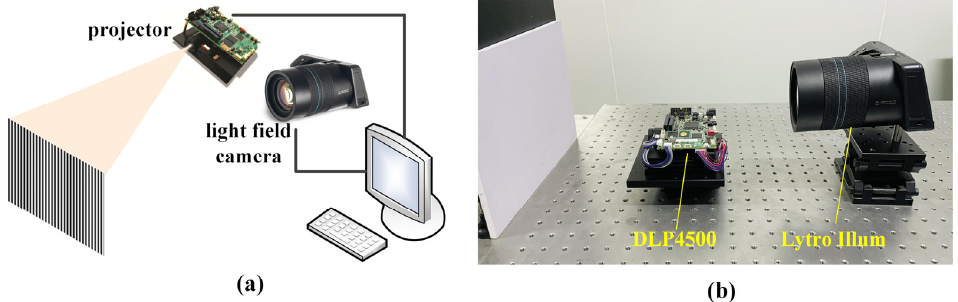
Figure 6. 3D reconstruction system based on a light field. ( a ) Schematic diagram; ( b ) Hardware Implementations.